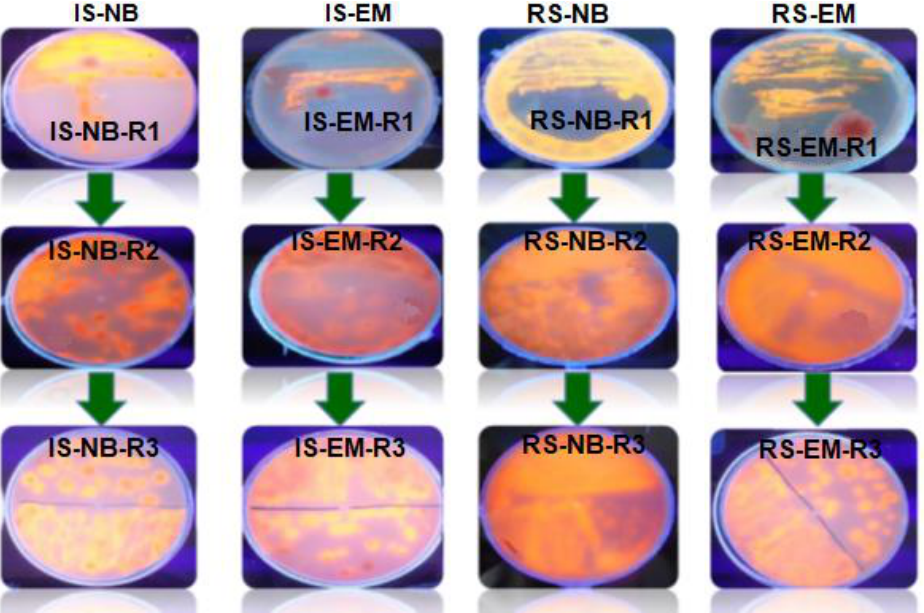
Figure 3. Isolation of lipase-producing microorganisms grown on plates with rhodamine B medium at 60 °C and pH of 5.4. IS-NB and IS-EM—initial seeding of microorganisms cultivated in NB and EM, respectively; 4RS-NB and 4RS-EM—four reseeding of microorganisms cultivated in NB and EM, respectively. IS: initial seeding.